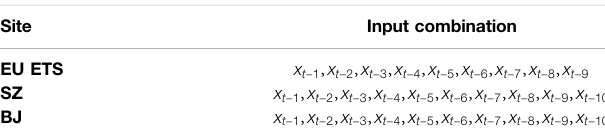
TABLE 5 | Optimal input characteristics based on the